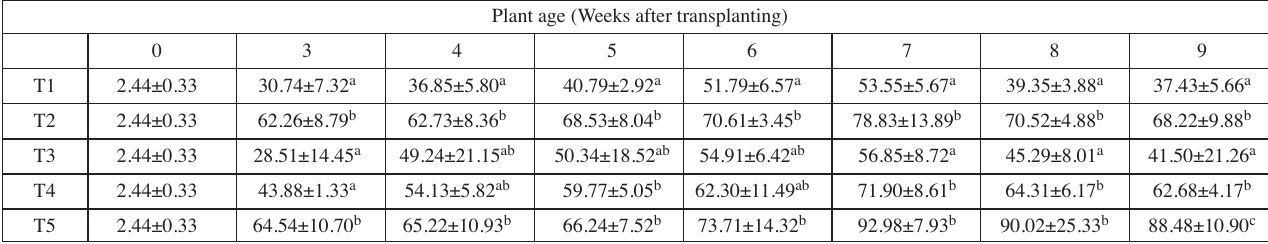
Plant age (Weeks after